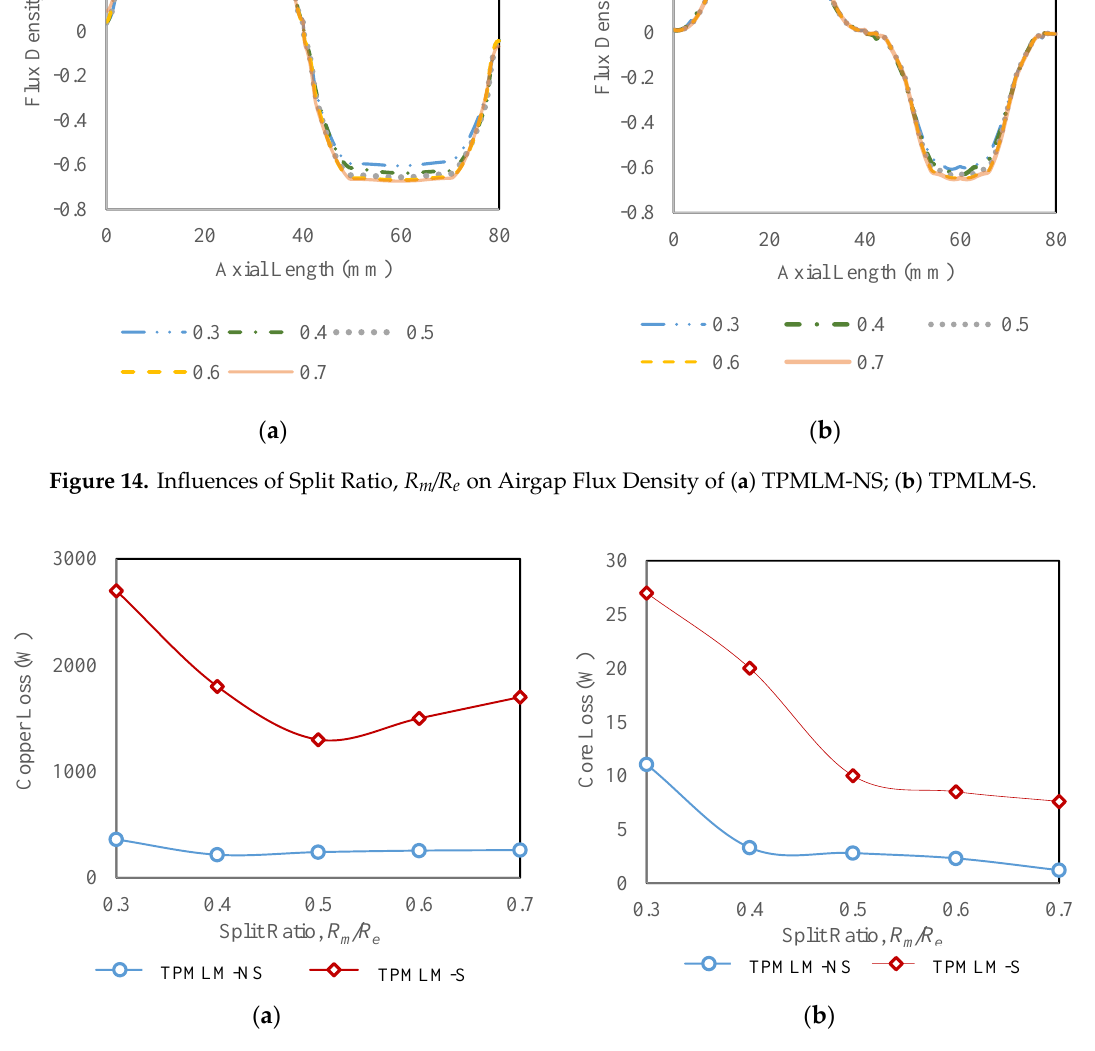
Figure 15. Influence of Split Ratio, R m /R e on Losses ( a ) Copper Loss; ( b ) Core Loss.